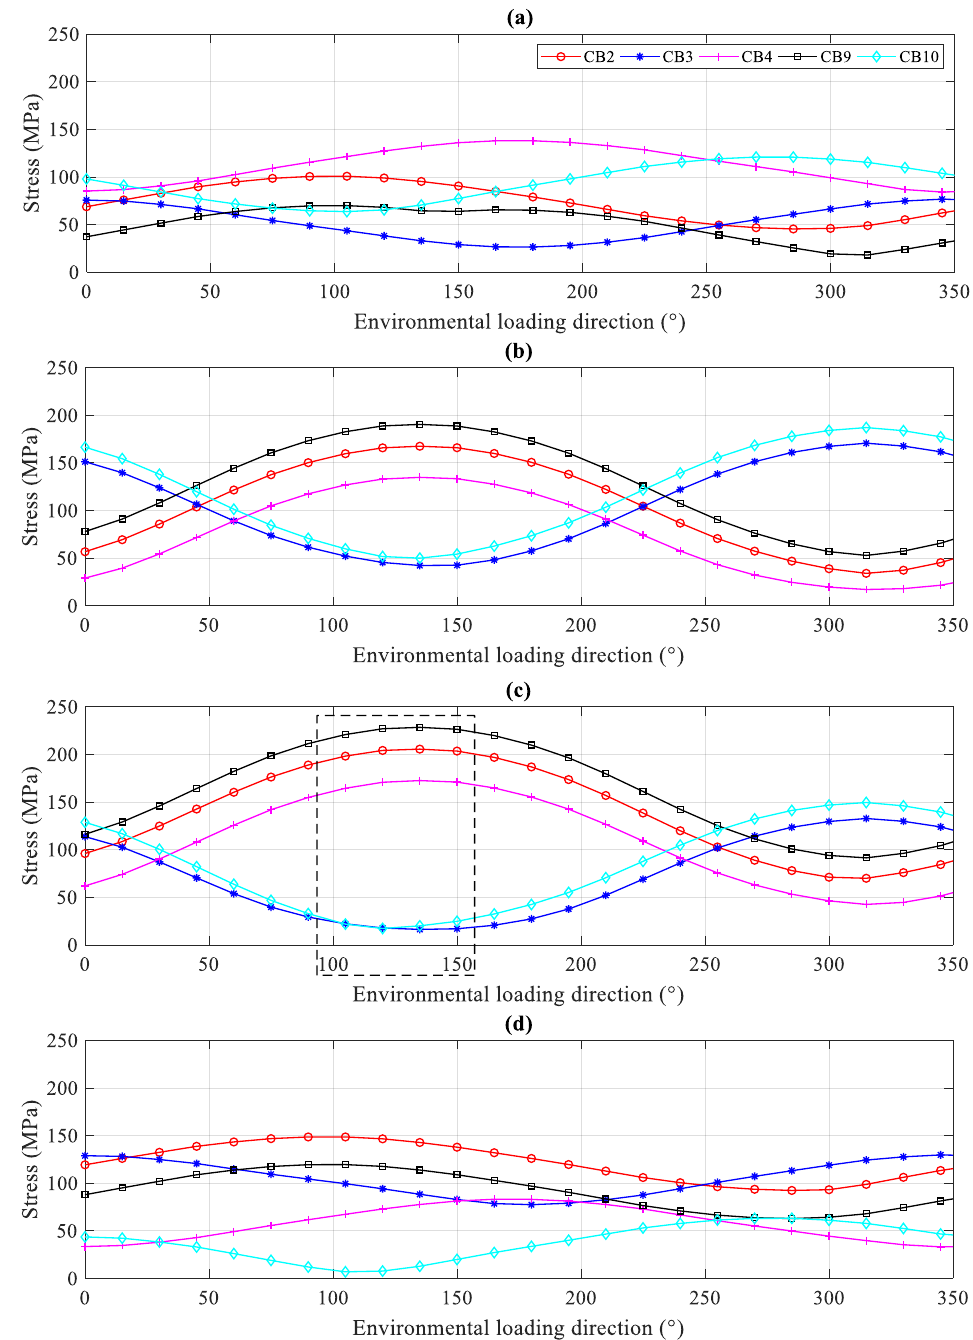
Figure 10. Stresses at lower jacket legs under combined loads: ( a ) Leg 1; ( b ) Leg 2; ( c ) Leg 3; ( d ) Leg 4.